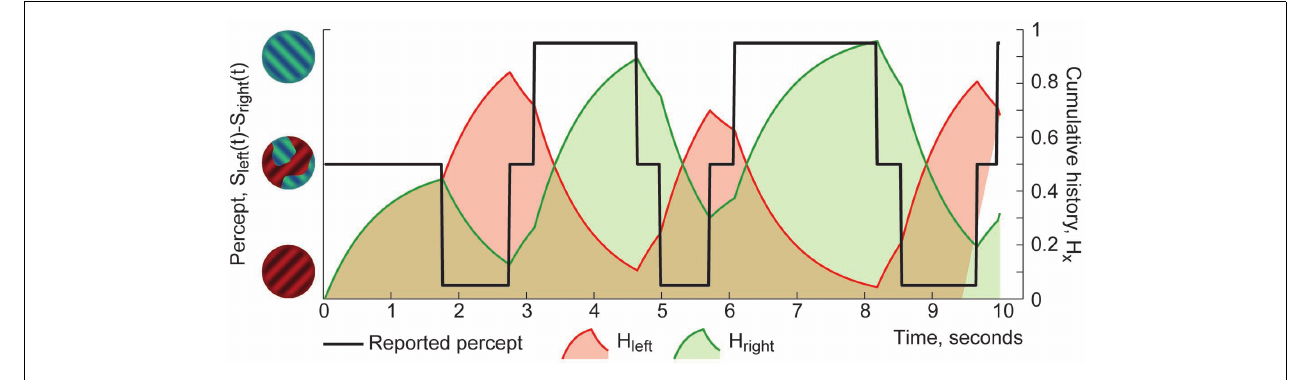
illustrate hypothetical cumulative histories (correspondingly, green for “green/left eye” percepts and red for “red/right eye”), computed with τ = 0.5· T H